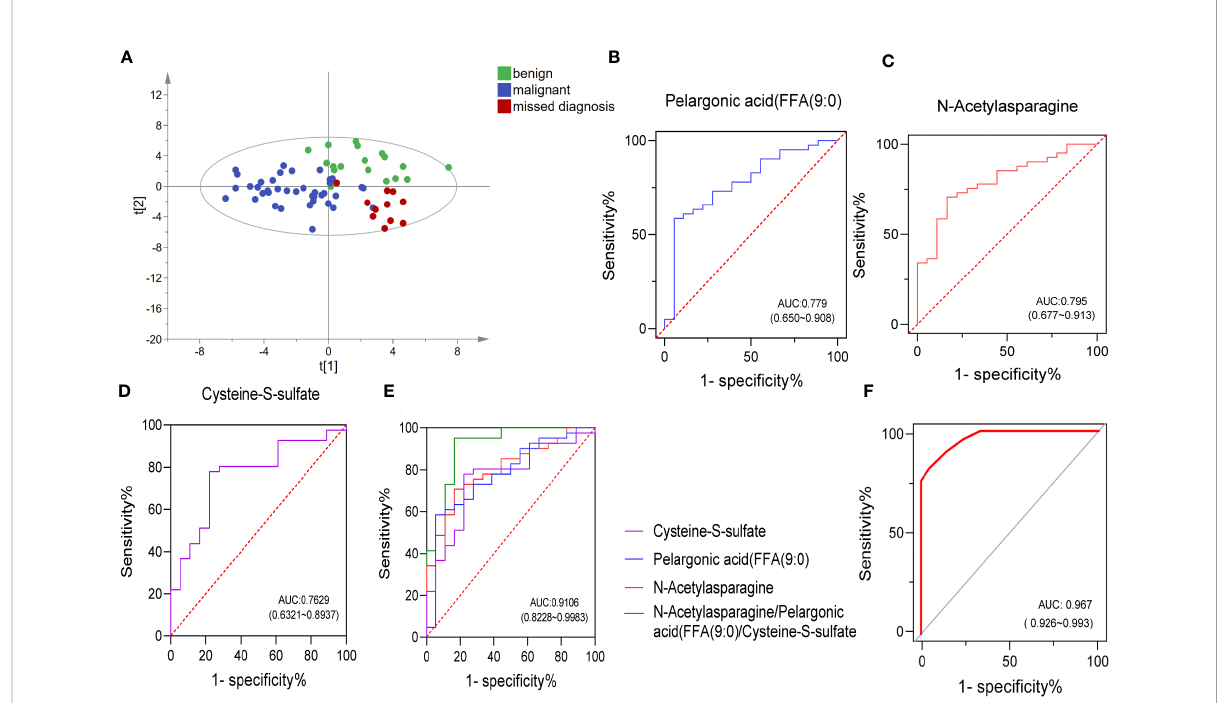
FIGURE 4 Combining a panel of metabolites and ABVS examination to improve the ef fi cacy of discriminating the malignant breast tumors from benign tumors. OPLS-DA score plots of metabolites among benign, malignant, and ABVS missed diagnosis group (A) . Receiver-operating characteristic (ROC) curves of the three biomarkers and their combination (B – E) . ROC curve analysis was used to intuitively show the effectiveness of the model (combing a panel of metabolites and ABVS performance) in distinguishing benign and malignant breast tumors (F)